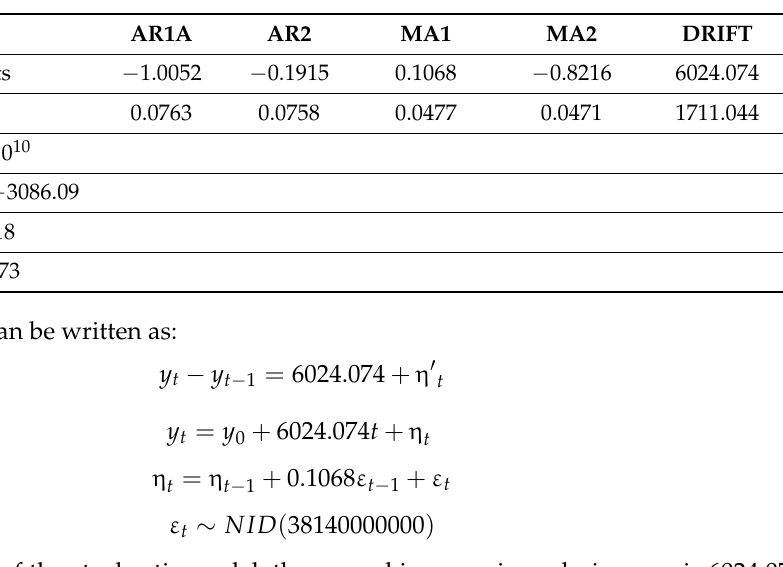
Table 5. Stochastic model (ARIMA (2,1,2).